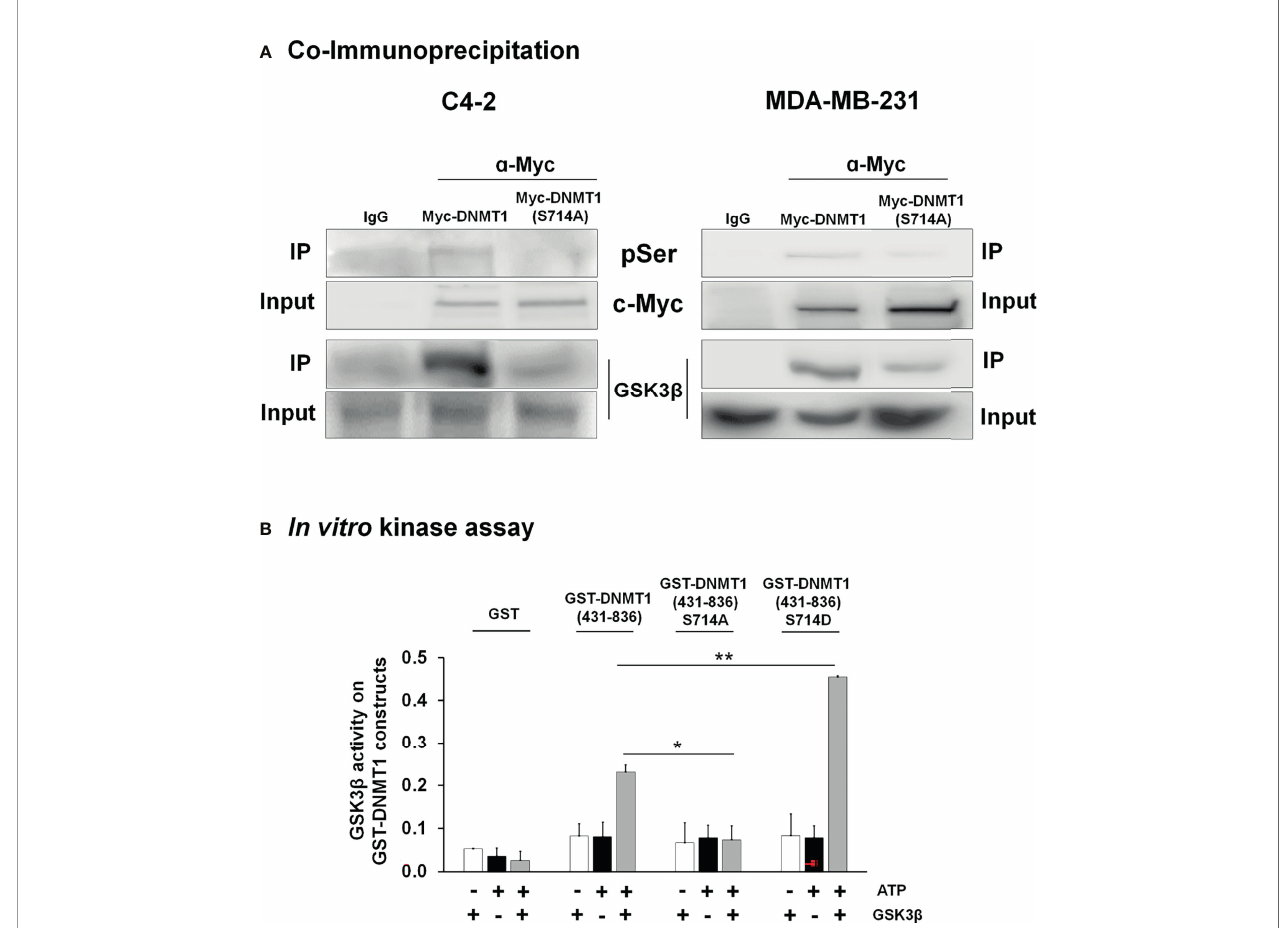
FIGURE 2 | GSK3 interacted with and phosphorylated DNMT1 (A) C4-2 and MDA-MB-231 cells were transfected with expression vector for either Myc-DNMT1 (WT) or Myc-DNMT1 (S714A). Myc-tagged proteins were immunoprecipitated using c-Myc antibody. Shown are immunoblot analyses of phosphorylated serine (pSer), Myc-tagged DNMT1, and GSK3 b . Figures are representative of at least 3 independent experiments. (B) In vitro kinase assays were performed using recombinant GSK3 b (0.1 µg), 100 µM ATP, and puri fi ed GST-DNMT1 constructs (1 µg) for 30 min at 30°C. Phosphoserine signal in reaction products was detected by ELISA wherein wells were coated with anti-GST antibody and reaction products incubated with anti-phosphoserine and HRP-linked secondary antibody. Negative controls in each experiment are samples lacking ATP or recombinant GSK3 b . *P<0.05 and **P<0.01 vs . GST-DNMT1 (WT). Figures are representative of at least 3 independent